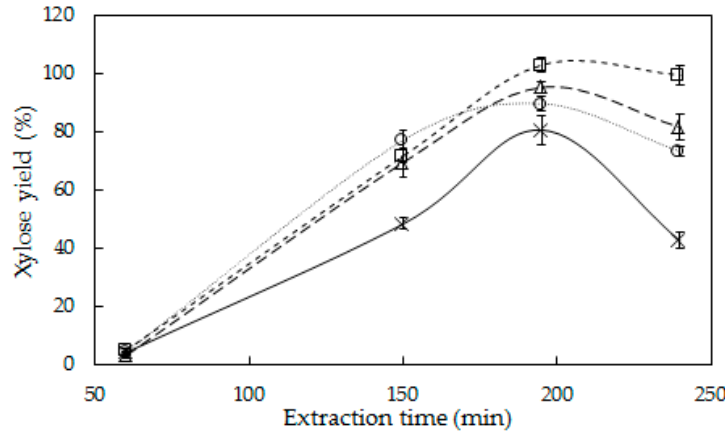
Figure 1. Xylose yields for hemicellulose extraction at an S/L ratio of 1:8 with different times and temperatures: (X) 145 °C, ( ○ ) 150 °C, ( ∆ ) 155 °C, and ( □ ) 160 °C. Lines are a guide to the eye. Table 3. Eucalyptus hemicellulose hydrolysate (EHH) partial composition for extractions at an S/L of 1:8.